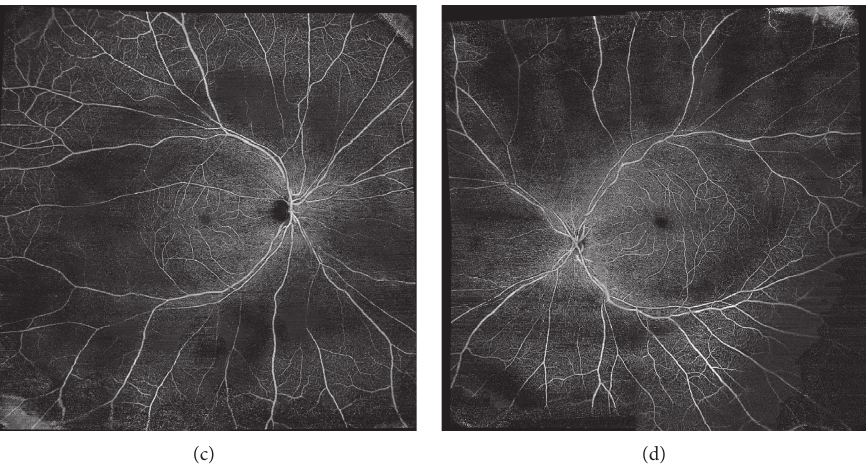
Figure 4: En face OCT-Angiography (Zeiss AngioPlex): (a) and (b) images of the patient’s right eye and left eye, respectively, showing posterior pole montage dropout of the superficial capillary plexus (SCP) corresponding to the areas of atrophy seen on cSLO. (c) and (d) Images showing findings in the offspring’s right eye and left eye, respectively.